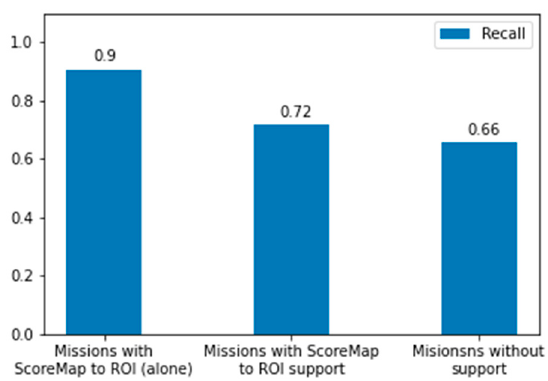
Figure 17. Results comparison between missions: the mission with the ScoreMap to ROI (algorithm alone), with the ScoreMap to ROI support, and without support.